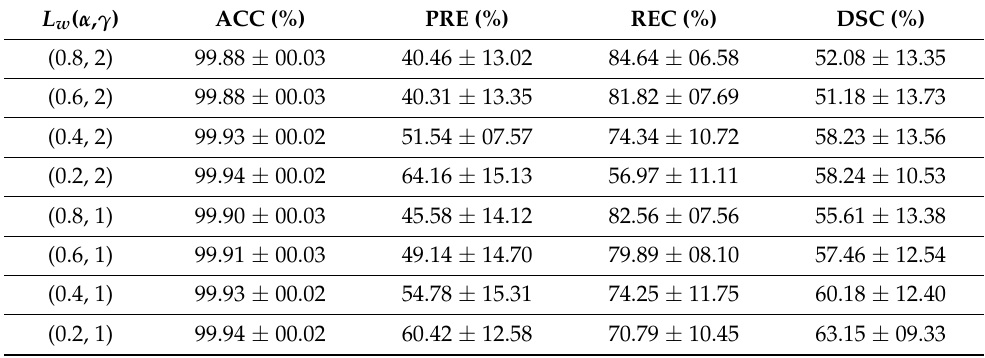
Table 5. ACC, PRE, REC, and DSC comparison of the segmentation with different parameters on weighted loss function (compared with the manual ground truth).